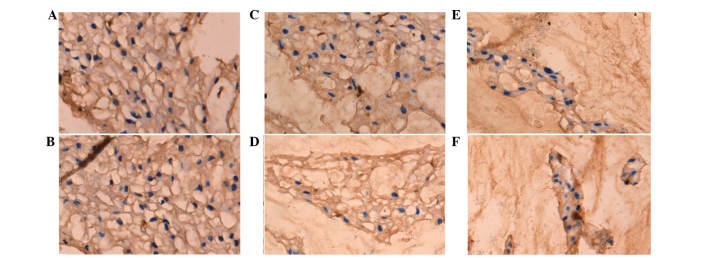
Photomicrographs showing the expression of collagen II in the disc samples. Immunohistochemical staining was used to show collagen I in the disc: (A), (C) and (E) show that the expression of collagen II was not significantly changed. (B), (D) and (F) show that the expression of collagen II significantly decreased over time. Original magnification, ×400.